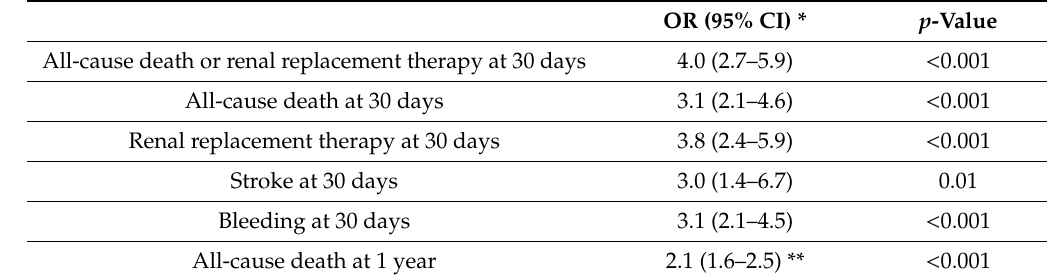
Table 3. Multivariable regression analyses for the association of MCS with primary and secondary